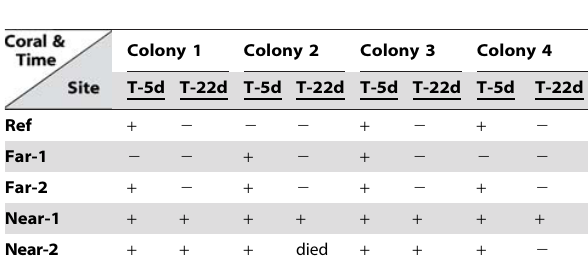
experiment. Desulfovibrio returned to undetectable levels for all colonies at all low-effluent sites by T-22 days (Ref, Far-1&2), yet remained detectable in most colonies at the high-effluent sites (Near-1&2).